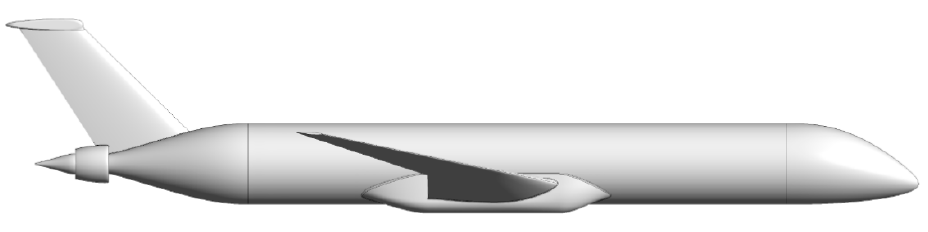
Figure 8. Side-view of the aerodynamic model of the PFC, including wing and vertical tail.